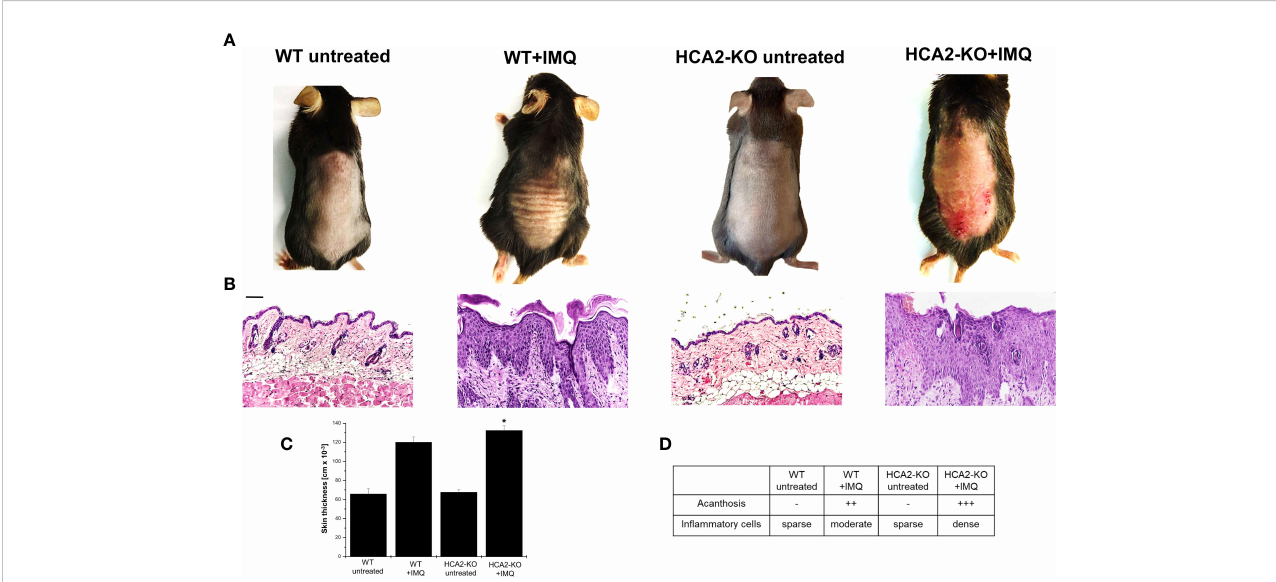
FIGURE 1 HCA2 de fi ciency enhances the susceptibility to psoriasis-like skin in fl ammation. (A) WT and HCA2-KO mice were treated topically with 5% IMQ cream on the shaved backs for 7 (d) (B) Biopsies were taken, paraf fi n embedded sections were stained with H&E and analyzed histopathologically. Each group contained 7 animals. Scale bar = 100 µm (C) Skin thickness was measured using a spring-loaded micrometer. Student t test and one-way ANOVA was performed. *P < 0.02 WT+IMQ vs HCA2-KO+IMQ; P ANOVA = 1.9 x10 -10 (D) Acanthosis and density of in fl ammatory in fi ltrate were scored. Data are presented from one of three independent experiments